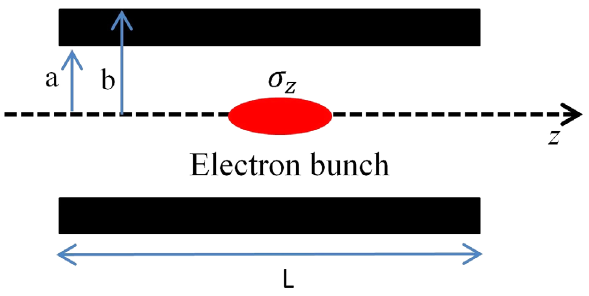
FIG. 1. DLW with relevant structure (not to scale).